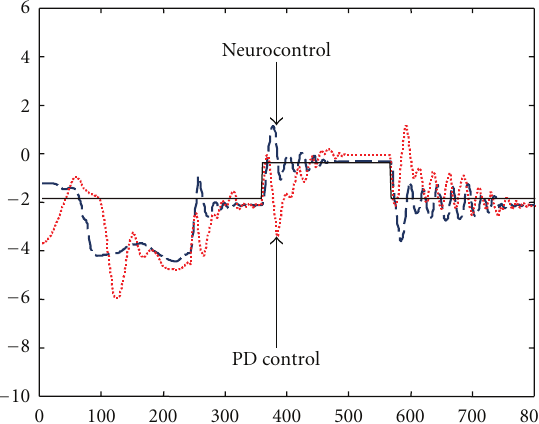
Figure 7: Tracking control of θ 2 (method